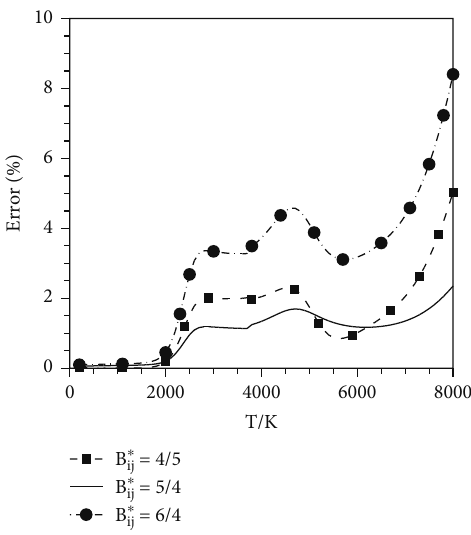
Figure 8: B ∗ ij between neutral